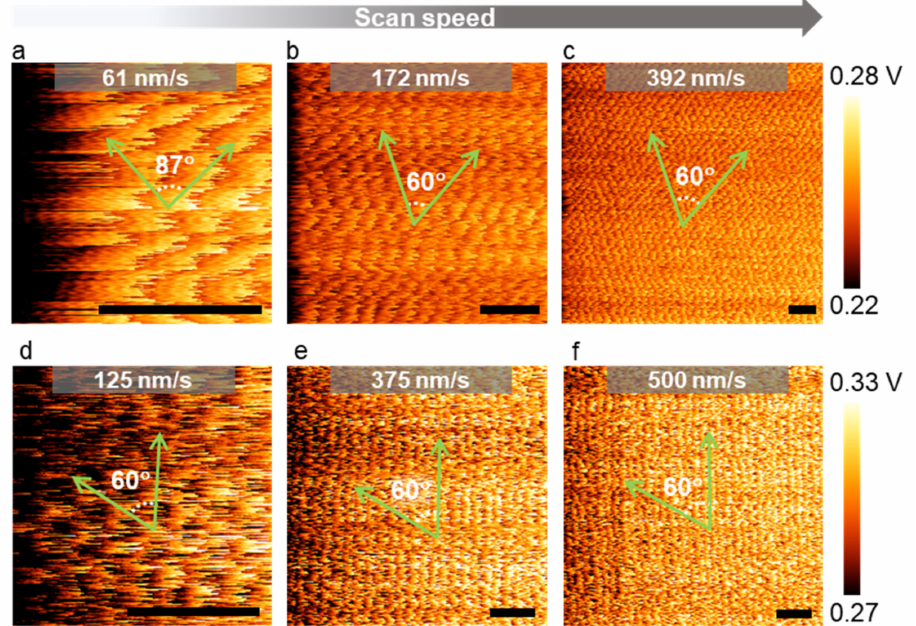
Figure 4. The effect of the scan speed on LFM lattice images (color range adjusted). ( a – c ) LFM raw data of MoSe 2 at various scan speeds (calibrated scale bar: 1 nm); ( d – f ) LFM raw data of graphene at various scan speeds (scale bar: 1 nm). All green arrows are aligned along the zigzag